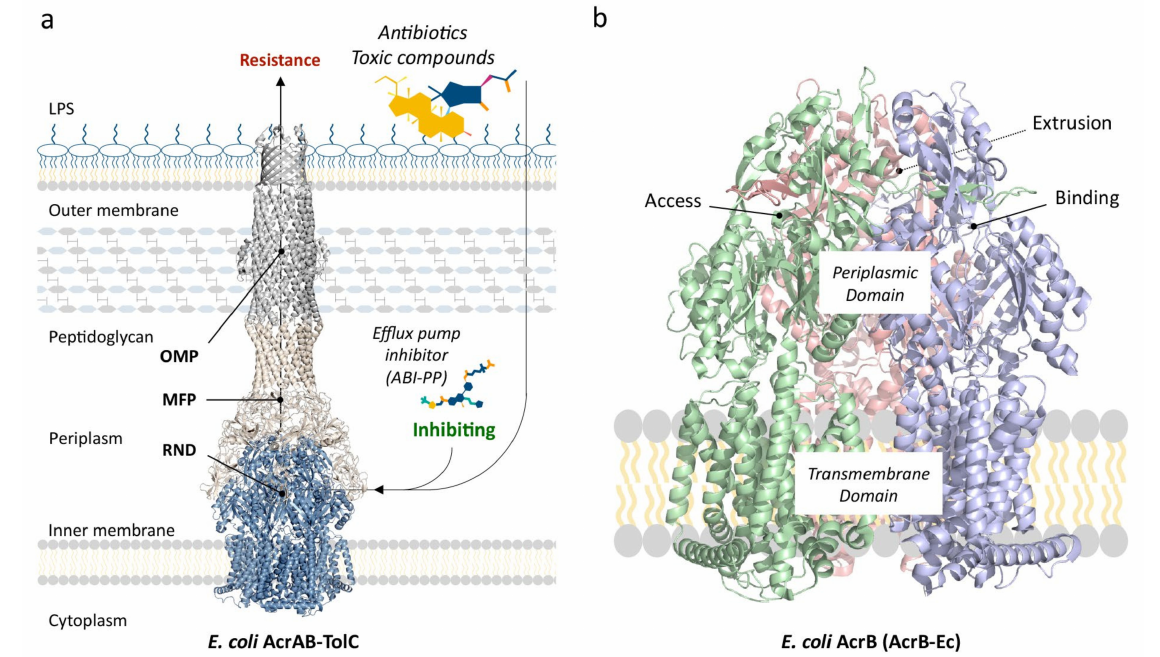
Figure 1. Structure of AcrAB–TolC-Ec and AcrB-Ec. ( a ) The structure of the tripartite complex AcrAB–TolC from Escherichia coli (PDB accession code 5O66 [48]). Antibiotics and other toxic compounds enter through the outer membrane and are captured by the RND efflux pump and consequently pumped out of the cells. ABI-PP is an efflux pump inhibitor (EPI), stopping the pump from functioning. ( b ) Structure of AcrB-Ec. Green shows the access monomer, blue the binding monomer and red the extrusion monomer (PDB accession code 3AOD [51]). Abbreviations: OMP, outer membrane protein; MFP, membrane fusion protein; RND, resistance-nodulation-division